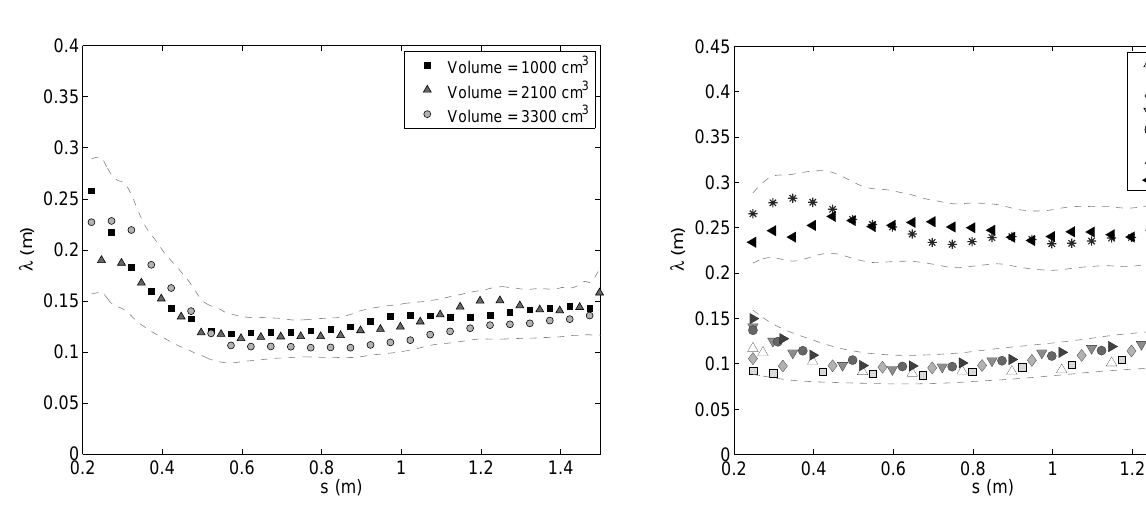
Fig. 7. Average wavelength ( λ ) versus distance from line release ( s ) for experiments using 2 . 7 ± 0 . 08mm diameter particles, plus or minus the standard deviation from the mean (dashed lines).